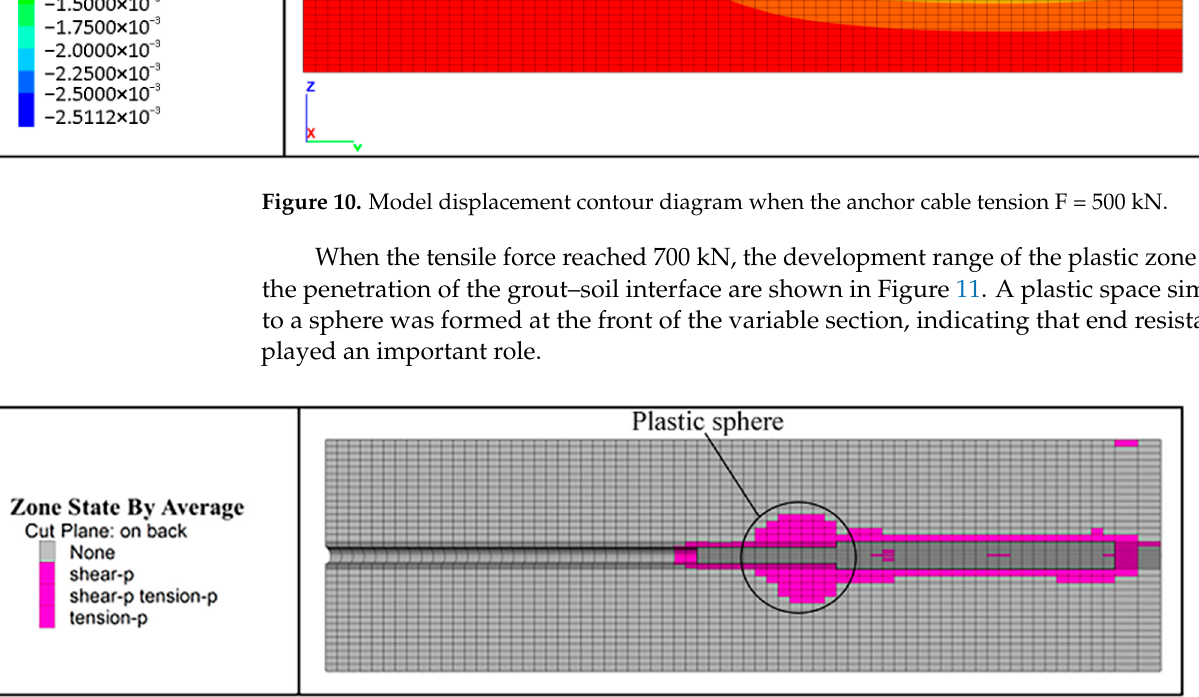
Figure 11. Plastic failure range at anchor cable pulling force 700 kN.